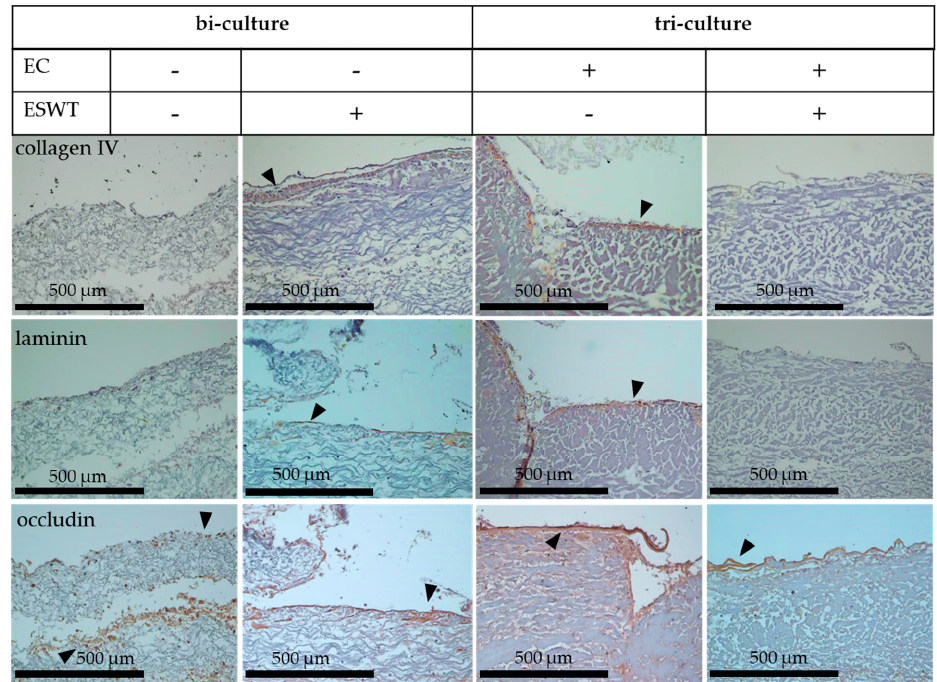
Figure 9. Formation of a basement membrane in bi-cultures (fibroblasts and epithelial cells) and in oral mucosa equivalents (tri-cultures of fibroblasts, epithelial cells, and endothelial cells) in ovo after treatment with ESWT on culture day 19. The formation of the basement membrane of tissue equivalents on chorioallantoic membrane (CAM) was examined in ESWT treated and untreated bi- cultures of fibroblasts and epithelial cells, and in ESWT treated and untreated oral mucosa equivalents (tri-cultures) of fibroblasts, epithelial cells, and endothelial cells (EC). Collagen IV (arrows) and laminin (arrows) were used as markers of the basement membrane. Occludin (arrows) is present in tight junctions and was used to analyze the functionality of the epithelial cell layers. The bi-cultures and oral mucosa equivalents were analyzed by immunohistochemistry. Consecutive sections from the samples were used for the staining with different antibodies. In the images, the cell occlusive side of the collagen matrix is directed upwards, and the porous side directed downwards. Scale bars represent 500 µ